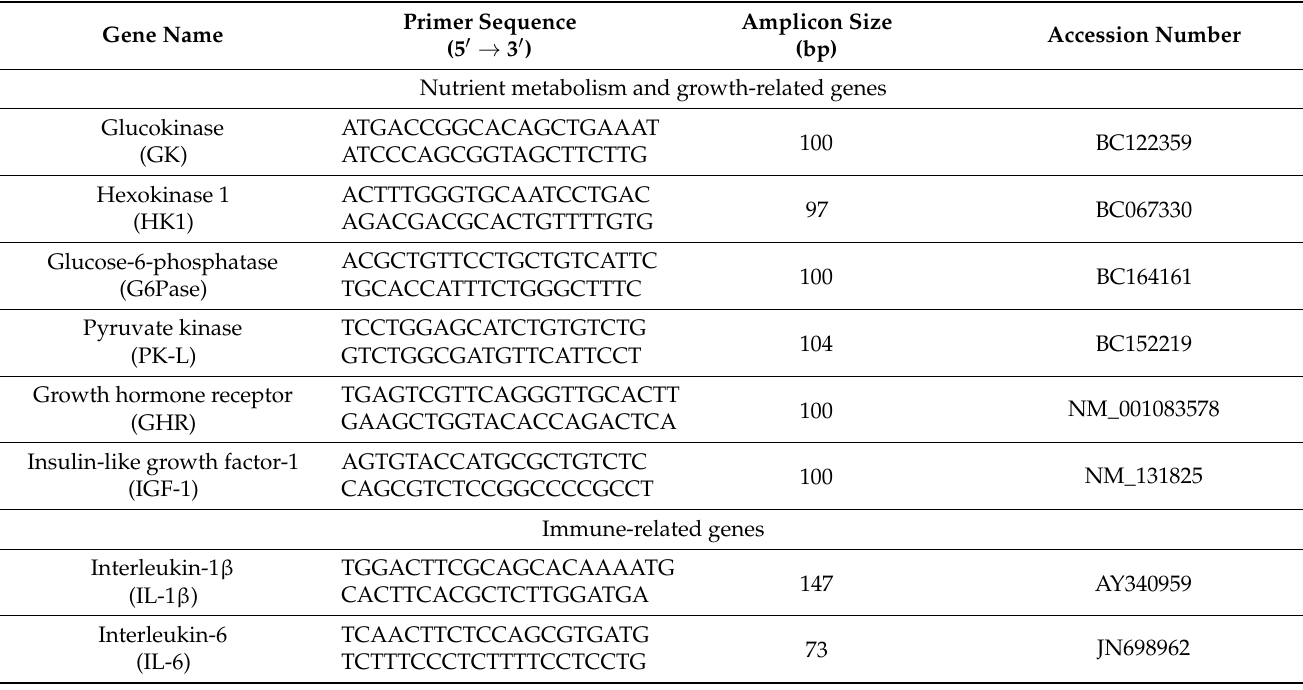
Table 1. Primer sequences used in this